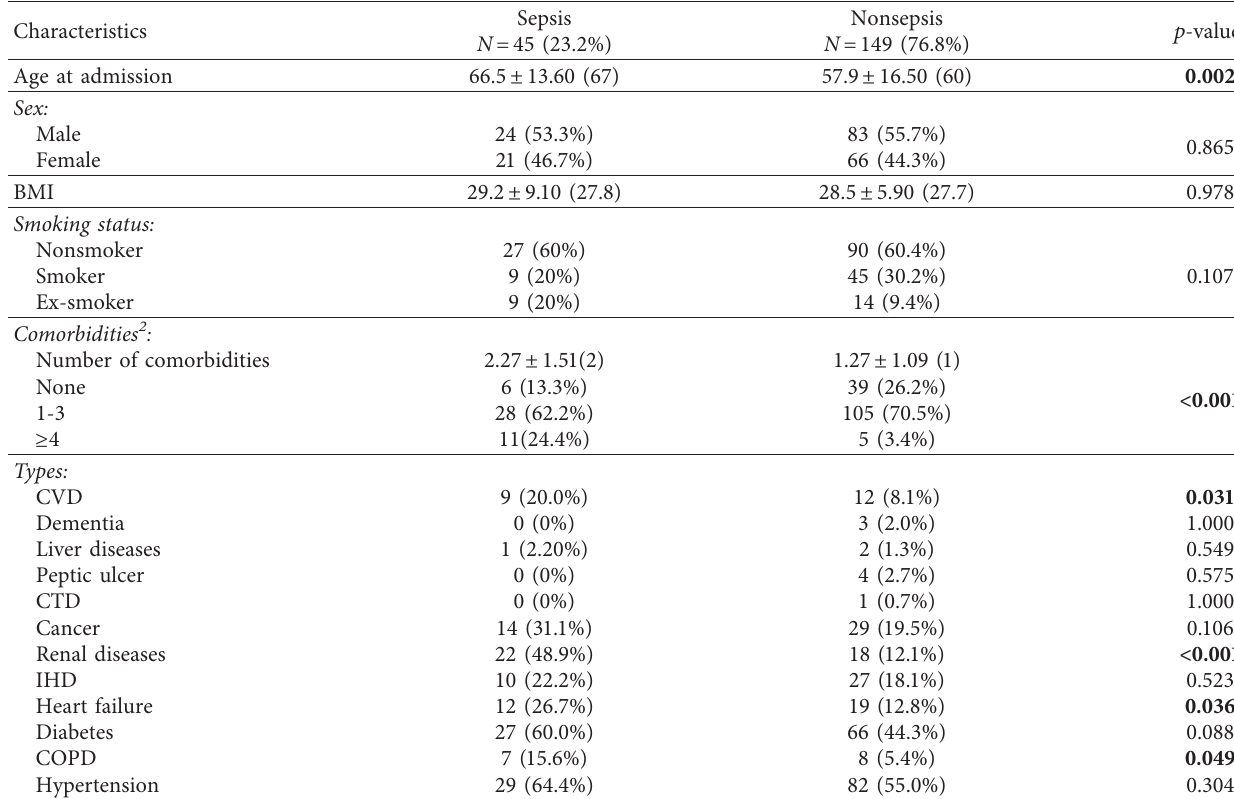
Table 3: Demographics and comorbidities of sepsis and nonsepsis